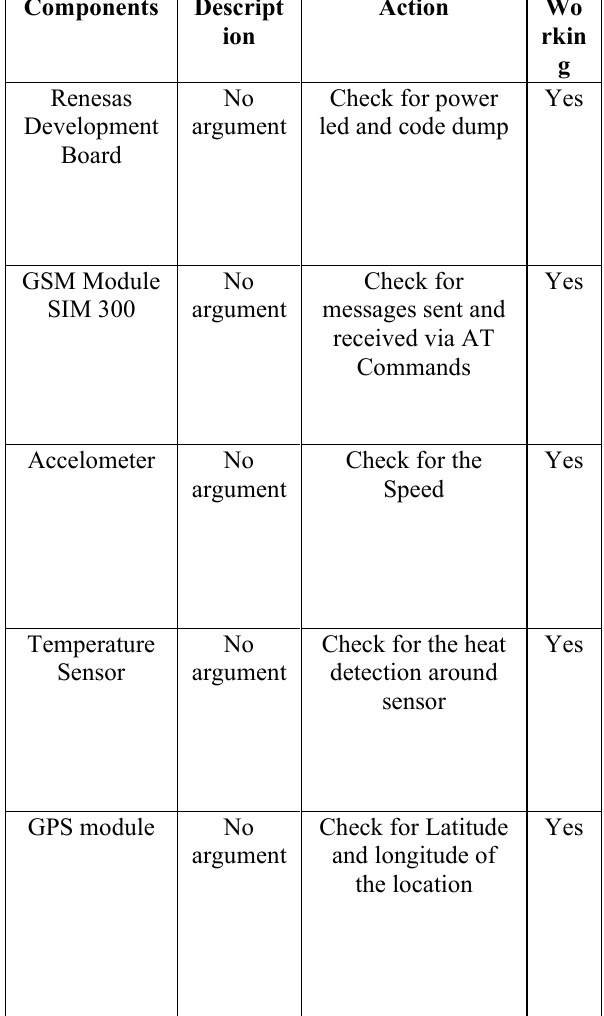
Table 1. Renesas Component